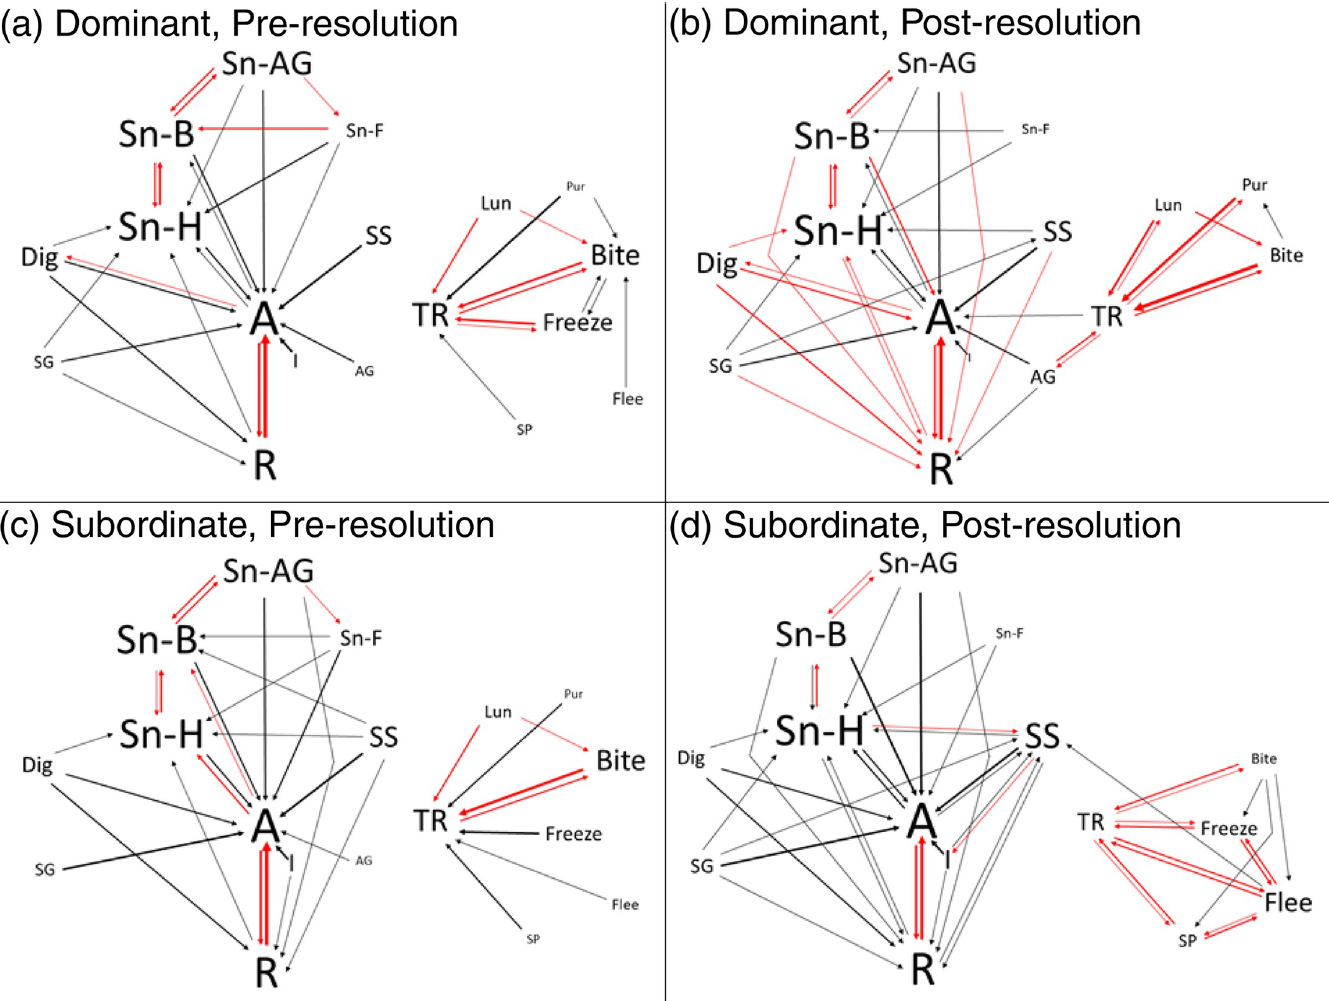
Fig 6. Kinetogram of transitions between behaviors for (A) dominants pre-resolution, (B) dominants post-resolution, (C) subordinates pre-resolution and (D) subordinates post-resolution. All transitions that occur with a median probability of above 0.075 are shown. Label size represents the relative frequency of each behavior. Line weight represents the relative transition probability. Red lines indicate transitions that occur at rates significantly greater than expected by chance. Abbreviations: A–moving, AG–allogrooming, Bite–biting, Dig–digging, Flee–fleeing, Freeze–freezing, I–inactive, Lun–lunge, Pur–pursuing, R–rearing, SG–self- grooming, Sn-AG–anogenital sniffing, Sn-B–body-sniffing, Sn-F–sniff-following, Sn-H–head-sniffing, SP–subordinate posture, SS–side-by-side contact, TR–tail rattling.